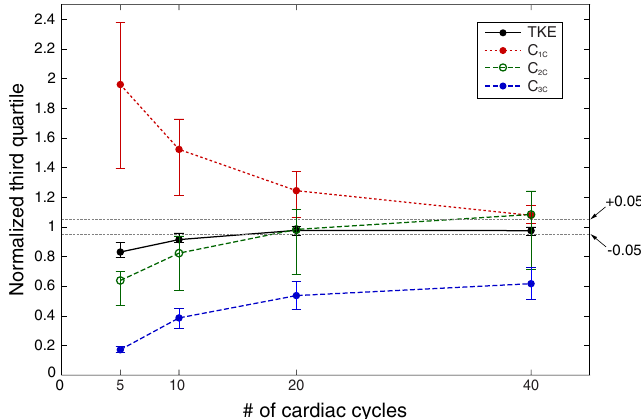
Figure 7. Third quartile phase-averaging tendency of the TKE and weights ( C iC ) of the barycentric anisotropy invariant map. Results were time- and spatial averaged over the EFD phase and the five post-stenotic cross-sections (0D to 3D, Figure 4), respectively. All Q 3 values were normalized by the reference value at 80 cardiac cycles. The markers and error bars indicate the mean and min/max Q 3 range over the assessed cross-sections,